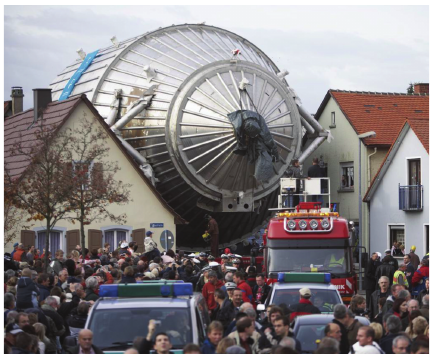
Figure 19: Schematic view of prespectrometer. (1) superconducting solenoids, (2) prespectrometer vessel, (3) inner electrode system, (4) 90 ∘ pump port, (5) 45 ∘ pump port, (6) insulator.